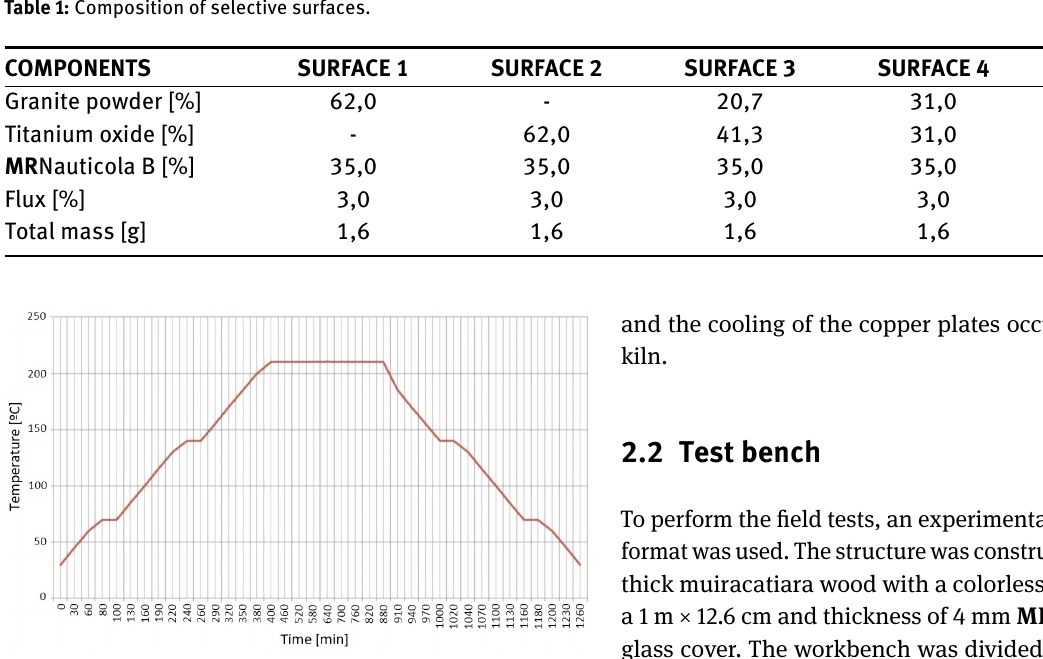
Figure 1: Sintering parameters of selective surfaces.